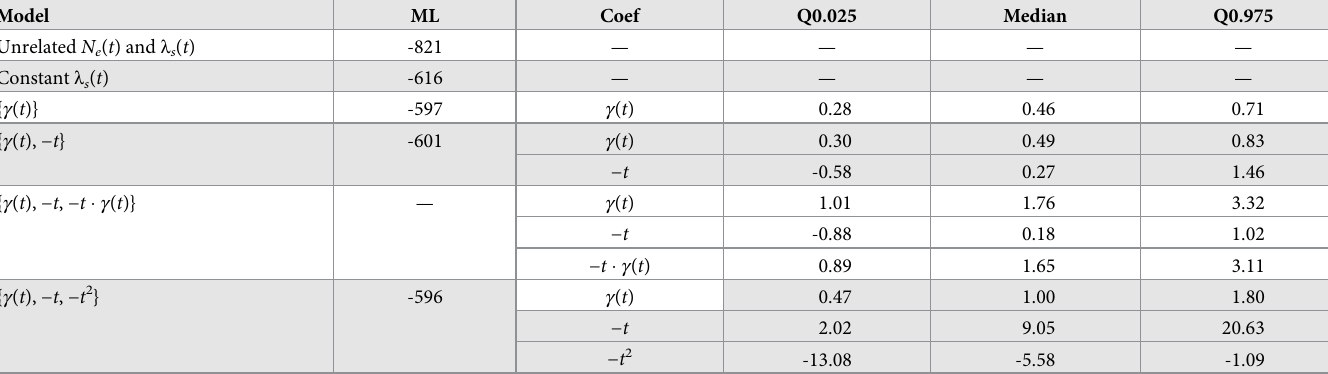
Table 4. Summary of Sierra Leone Ebola sequence data inference. Posterior distribution quantile summaries for BEAST implementation of BNPR-PS models: with no covariates (model: { γ ( t )}), with an ordinary covariate (model: { γ ( t ), − t }), with both an ordinary and interaction covariate (model: { γ ( t ), − t , − t � γ ( t )}),and with linear and quadratic ordinary covariates (model: { γ ( t ), − t , − t 2 }). Using a fixed tree, we also include marginal likelihoods (MLs) for all of the above models with no interactions, plus a model with